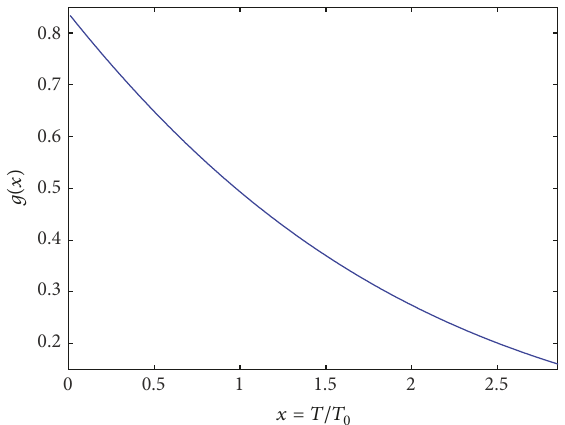
Figure 1: The shape of the spectrum of the emitted electrons in sterile neutrino-electron